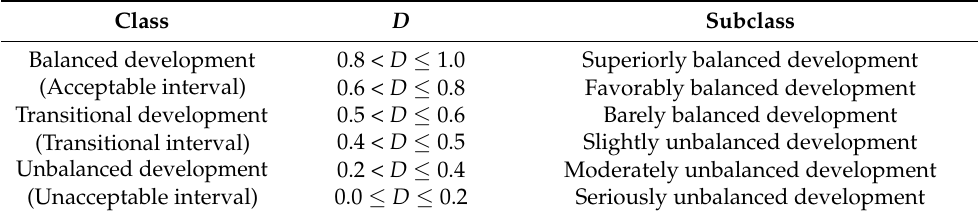
Table 3. Classification standard for degree of coupling